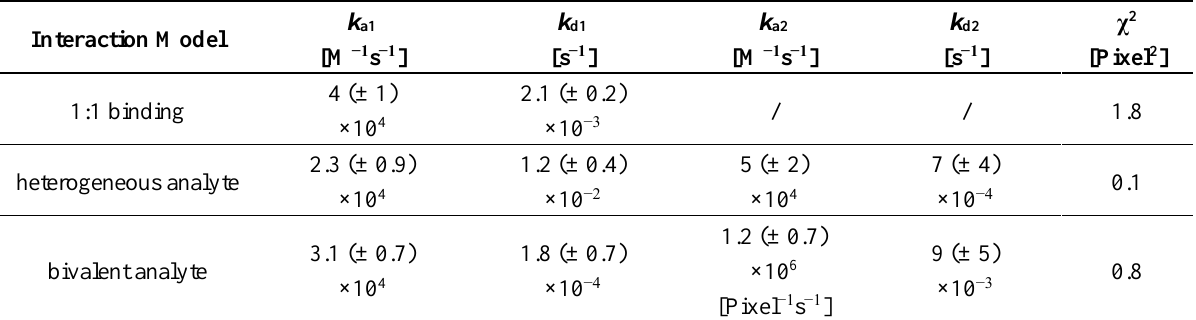
Table 1. Kinetic parameters obtained from local fitting of the interaction between the immobilized HSA and HSA-specific antibody for each mathematical model. The average rate constant and standard error of the local fit values for each model are